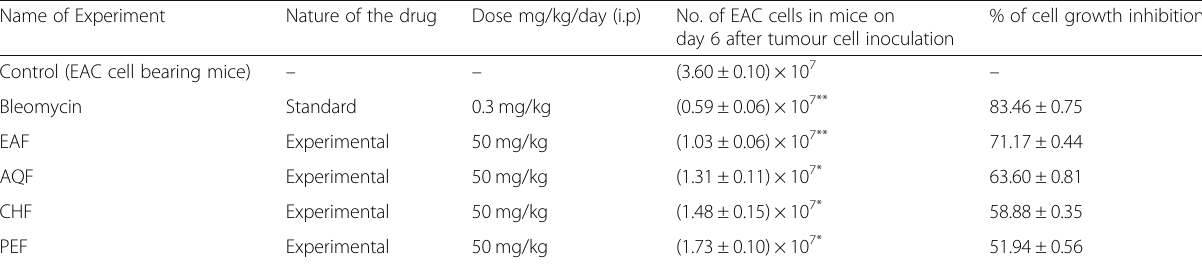
Table 4 Effect of EAF with other fractions on EAC cell growth inhibition in mice (in